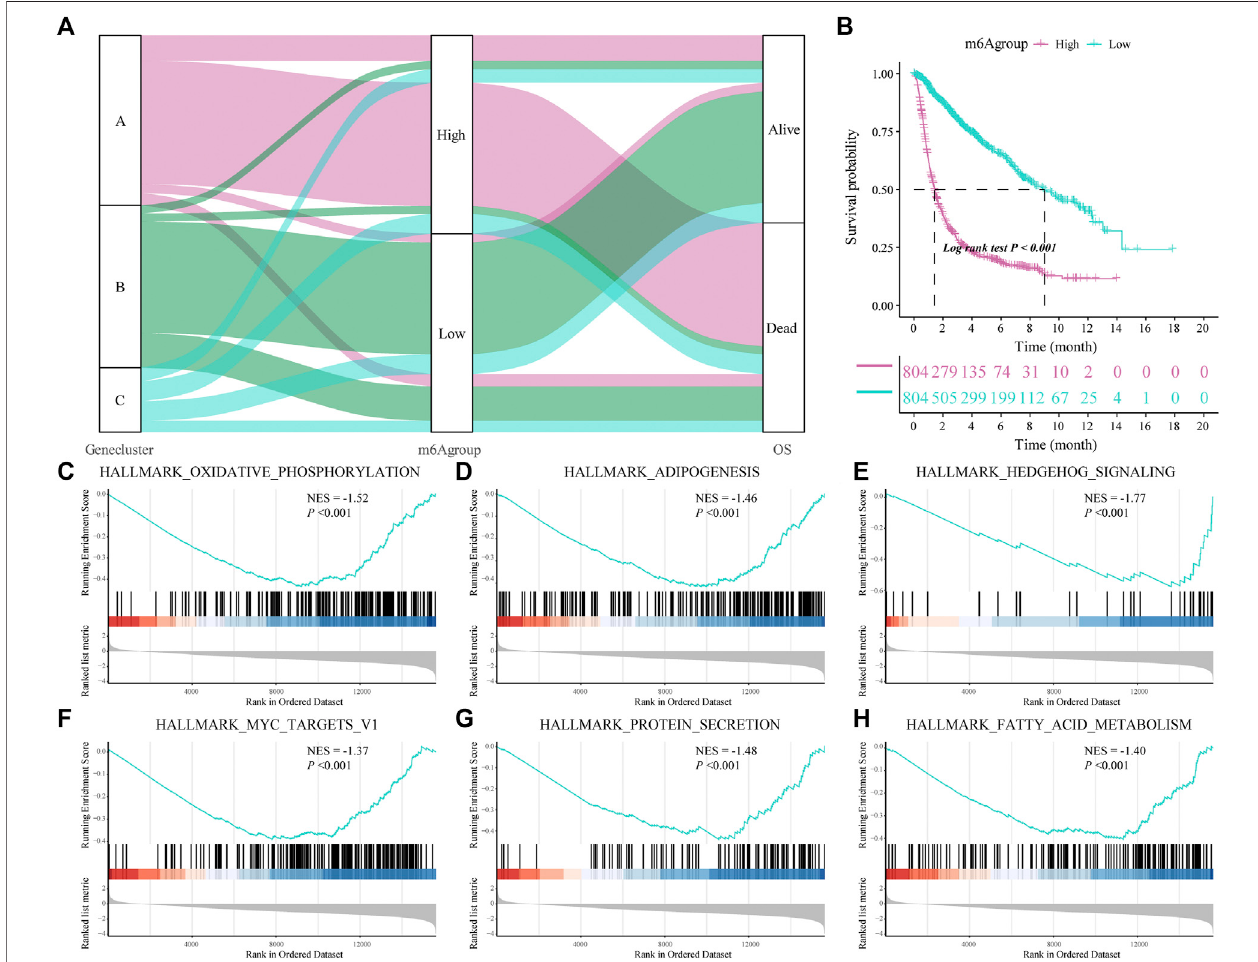
FIGURE 5 | Construction of a prognostic-related m6A characteristic model and regulation of biological processes. (A) The sankey diagram shows the correlation between gene clusters, prognostic-related m6A features (m6Agroup), and patient prognostic status (OS); (B) Survival analysis shows that the prognostic-related m6A feature model can better predict the overall survival rate of glioma patients (Log-rank p < 0.001); (C – H) gene-set enrichment analysis (GSEA) of high- and low-risk patients, the representative gene set downloaded from the MSigDB database, with 1,000 repetitions for each run; GSEA results show that enriched genes of glioma patients in the low m6A group are closely related to hallmark oxidative phosphorylation, adipogenesis, hedgehog signaling and MYC Target